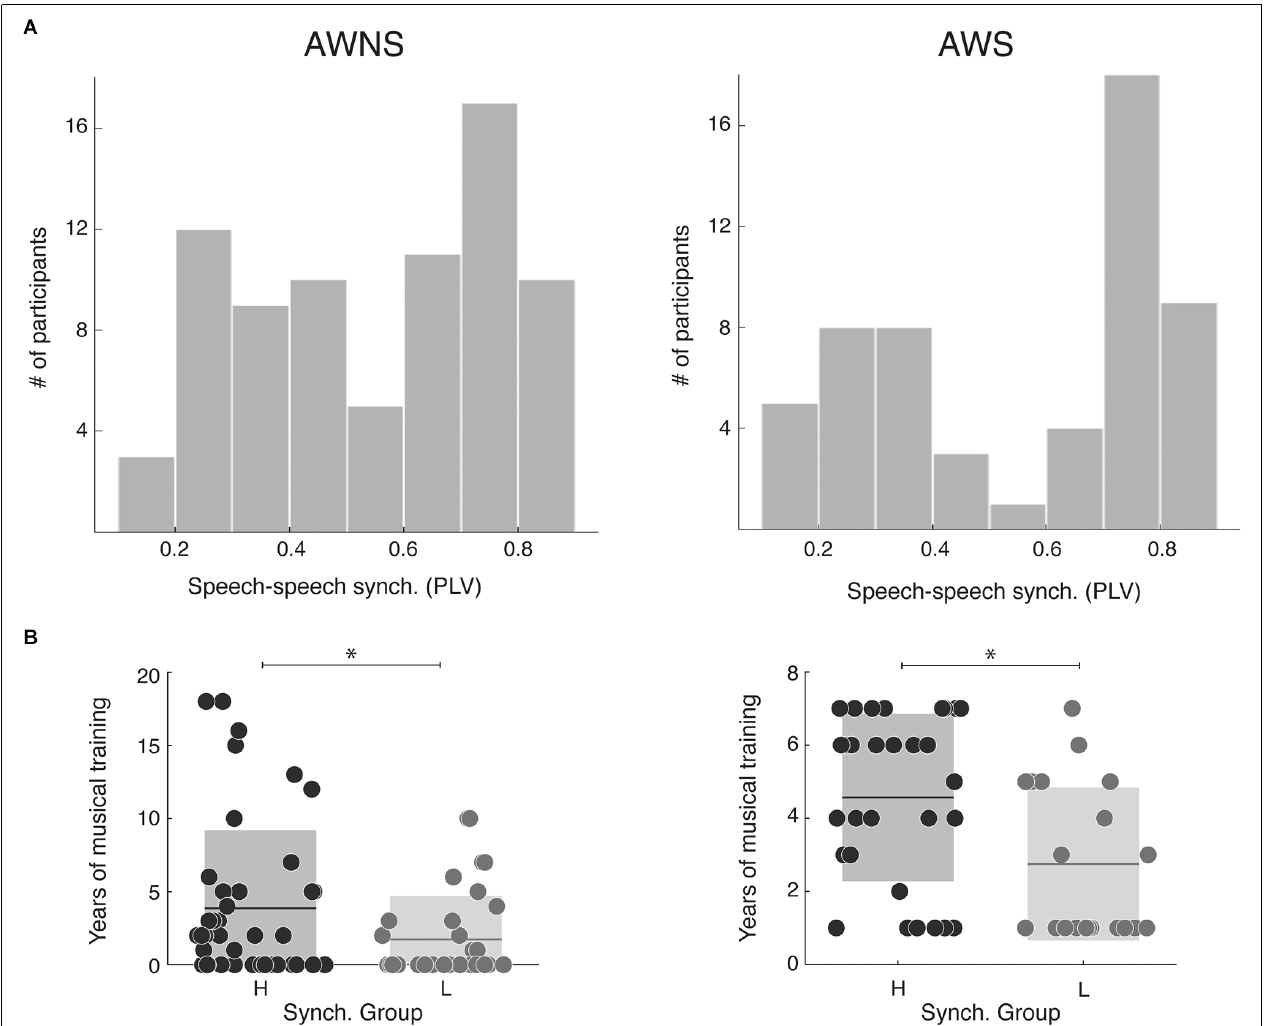
FIGURE 1 | SSS-test outcome. (A) Distribution of the speech-to-speech synchronization measurements (left: 77 adult stutterers; right: 56 adult non-stutterers). For both cohorts, the model better adjusting the data is a Gaussian mixture distribution with two components (Stutterers: Component 1, mixing proportion: 0.57, mean: 0.78; Component 2, mixing proportion: 0.43, mean: 0.29. Non-stutterers: Component 1, mixing proportion: 0.54, mean: 0.73; Component 2, mixing proportion: 0.46, mean: 0.34). (B) Years of musical training for each synchrony group. On the leftnon-stutterers, on the right the stutterers. For both populations, high synchronizers have significantly more years of training than lows (Mann-Whitney-Wilcoxon test, non-stutterers: two-sided p = 0.046, stutterers: two-sided p = 0.0038). ∗ p >